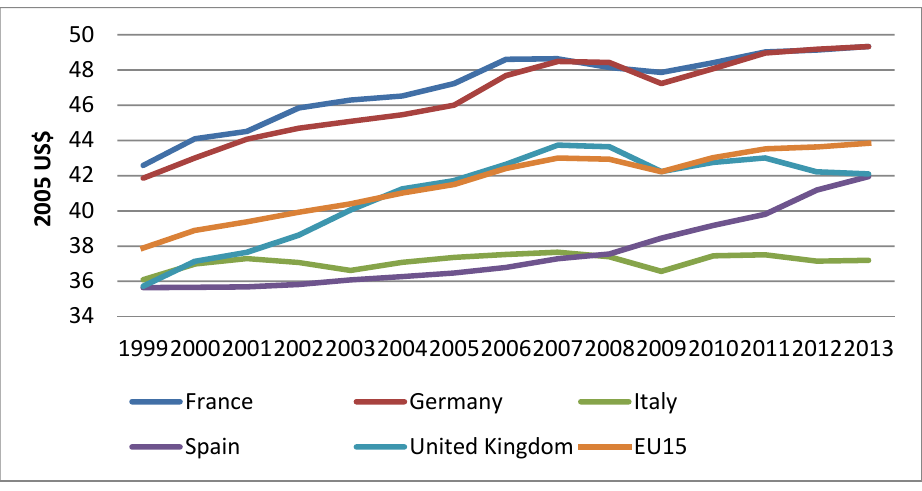
Figure 3. Labour productivity (GDP per hour worked) in constant terms